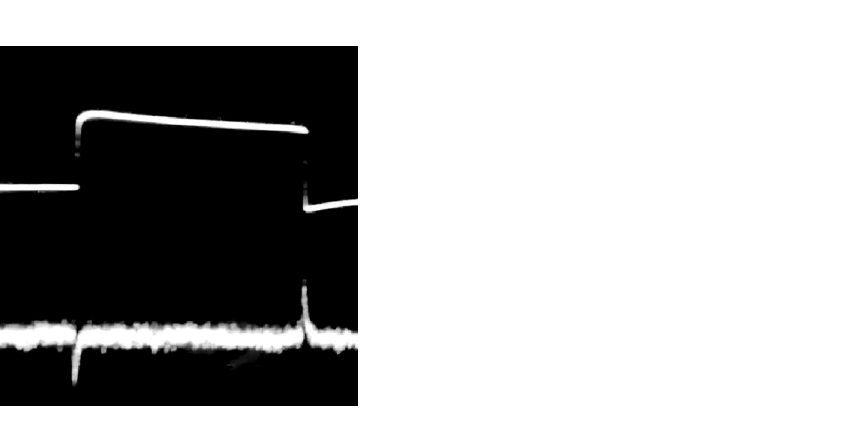
Figure 8. The upper beam is an acoustic signal in a 2 L container. The lower one is an electrical signal, which appears in the solution as the acoustic wave passes, recorded by silver chloride electrodes. The polarity of the electrical signal depends on the orientation of the electrodes relative to the acoustic